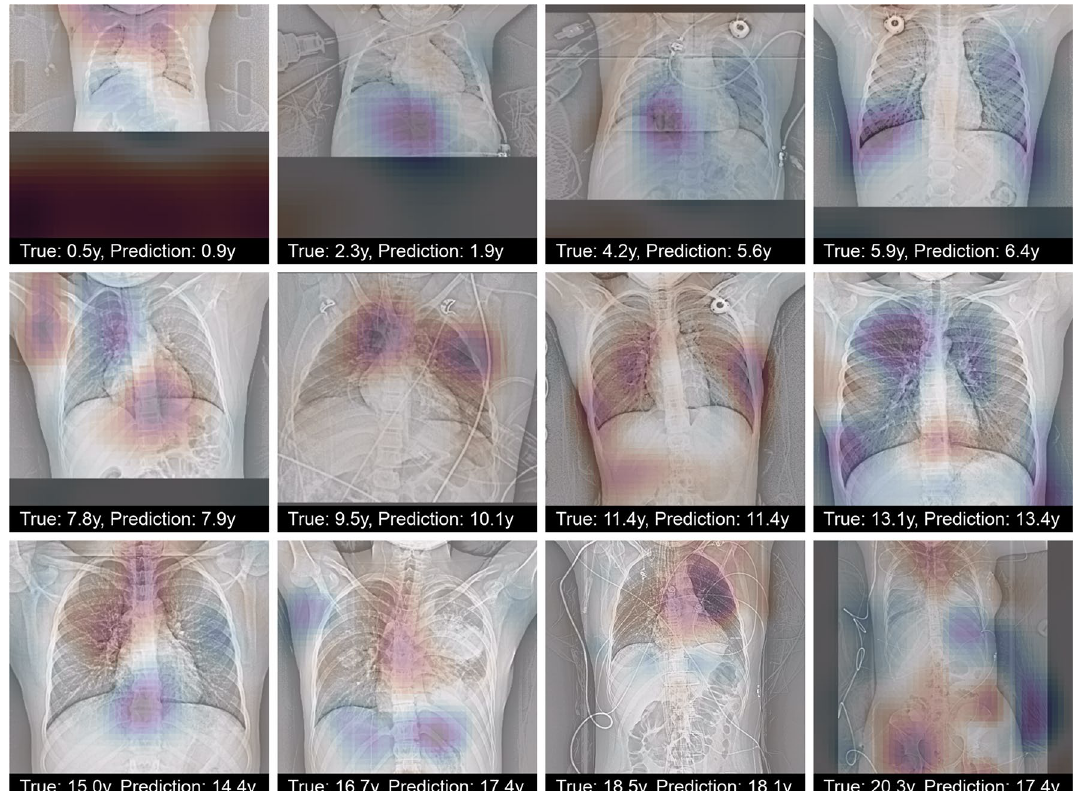
Figure 8. Occlusion maps for the optimized network for selected scout views from the test set. Scout views were selected evenly within the age range. Regions with darker color contributed more to age regression. The occlusion of red regions increased the prediction of the network compared to the prediction using the whole image, and the occlusion of blue regions decreased